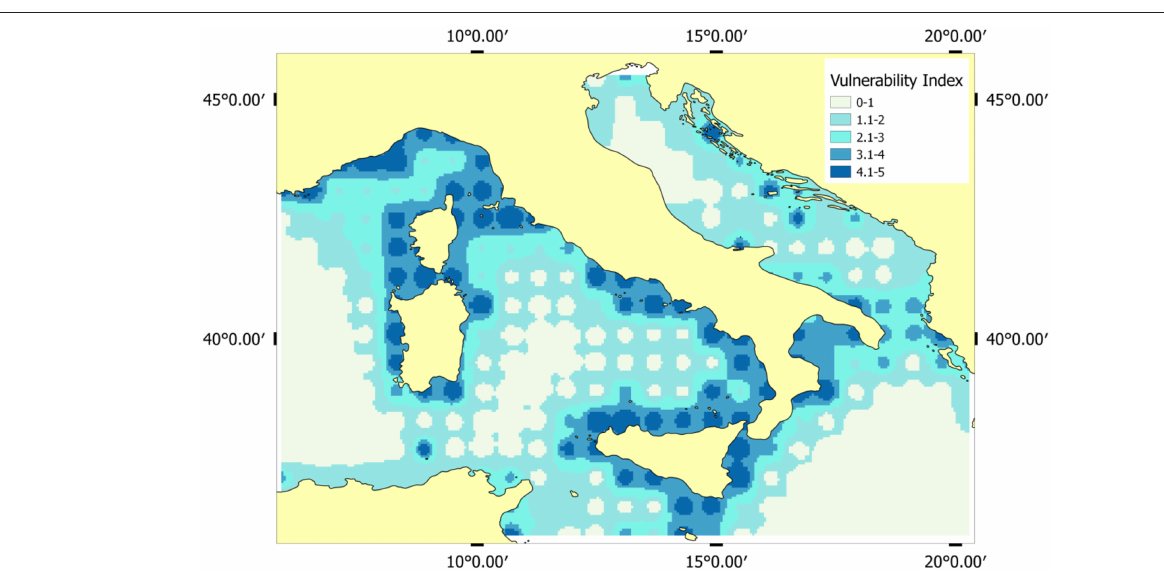
FIGURE 9 | Map of the HCA clusters. The 400m bathymetry is also shown.